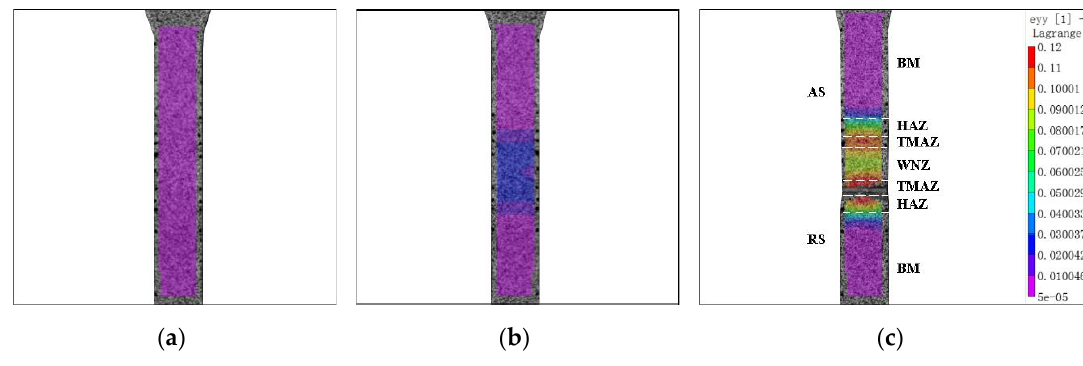
Figure 7. Tensile strains under tensile stresses of ( a ) 140 MPa, ( b ) 470 MPa, and ( c ) 530 MPa.